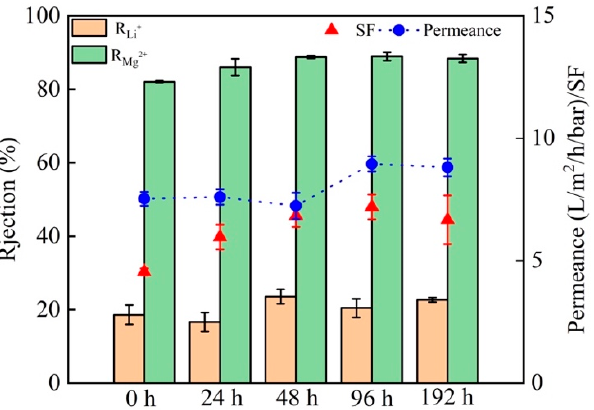
Figure 8. Effects of fabrication conditions on membrane separation performance and permeance. ( a ) PEI concentration; ( b ) immersion time of PEI; ( c ) TMC concentration; ( d ) reaction time; ( e ) g-C 3 N 4 concentration; ( f ) immersion time of DA.